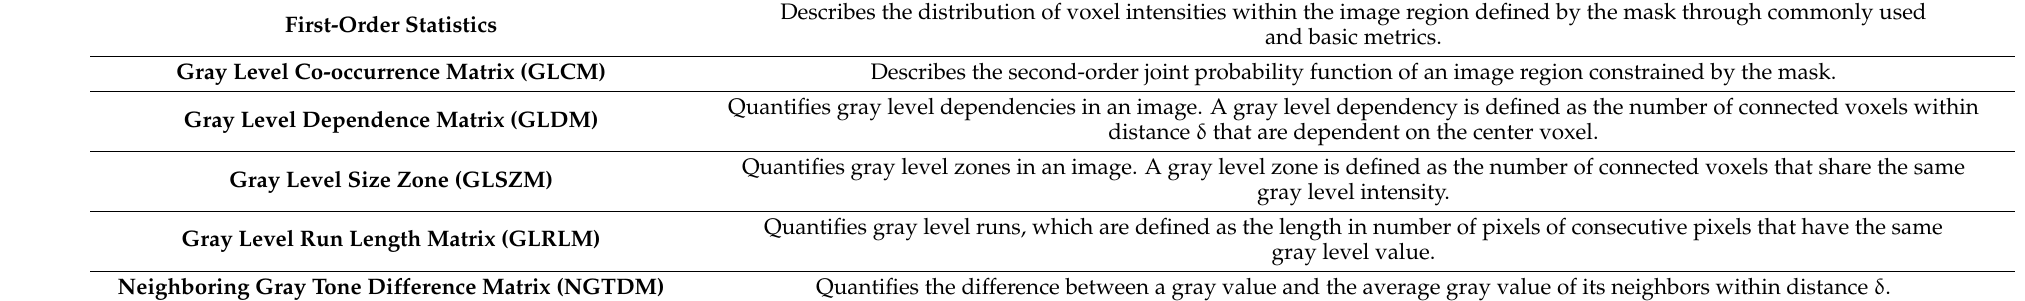
Table A2. Texture features